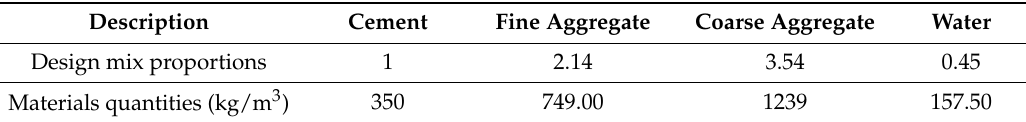
Table 1. Proportions of design mix.